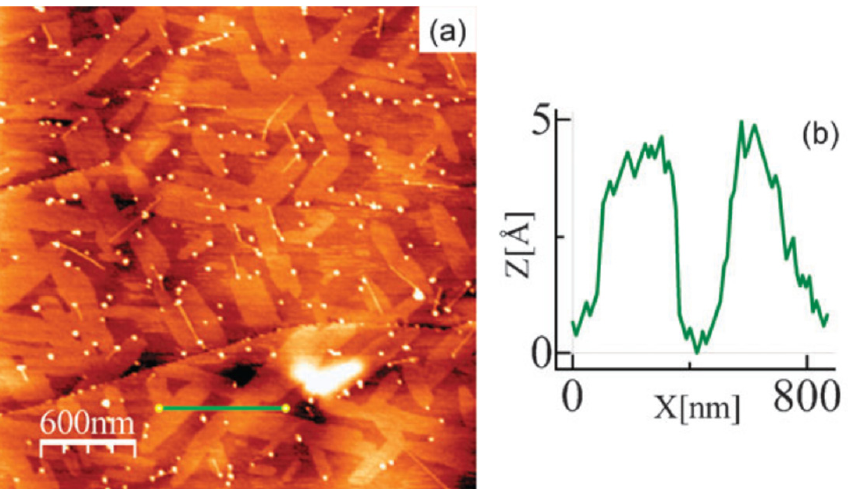
Figure 4. One-atom thick flakes of a Cu-based MOF obtained by top-down sonication method deposited on highly oriented pyrolytic graphite. ( a ) shows the topography image obtained using Atomic Force Microscope (AFM) and ( b ) depicts the height profile obtained along the green line in ( a ). Used with permission of [49]; permission conveyed through Copyright Clearance Center, Inc.